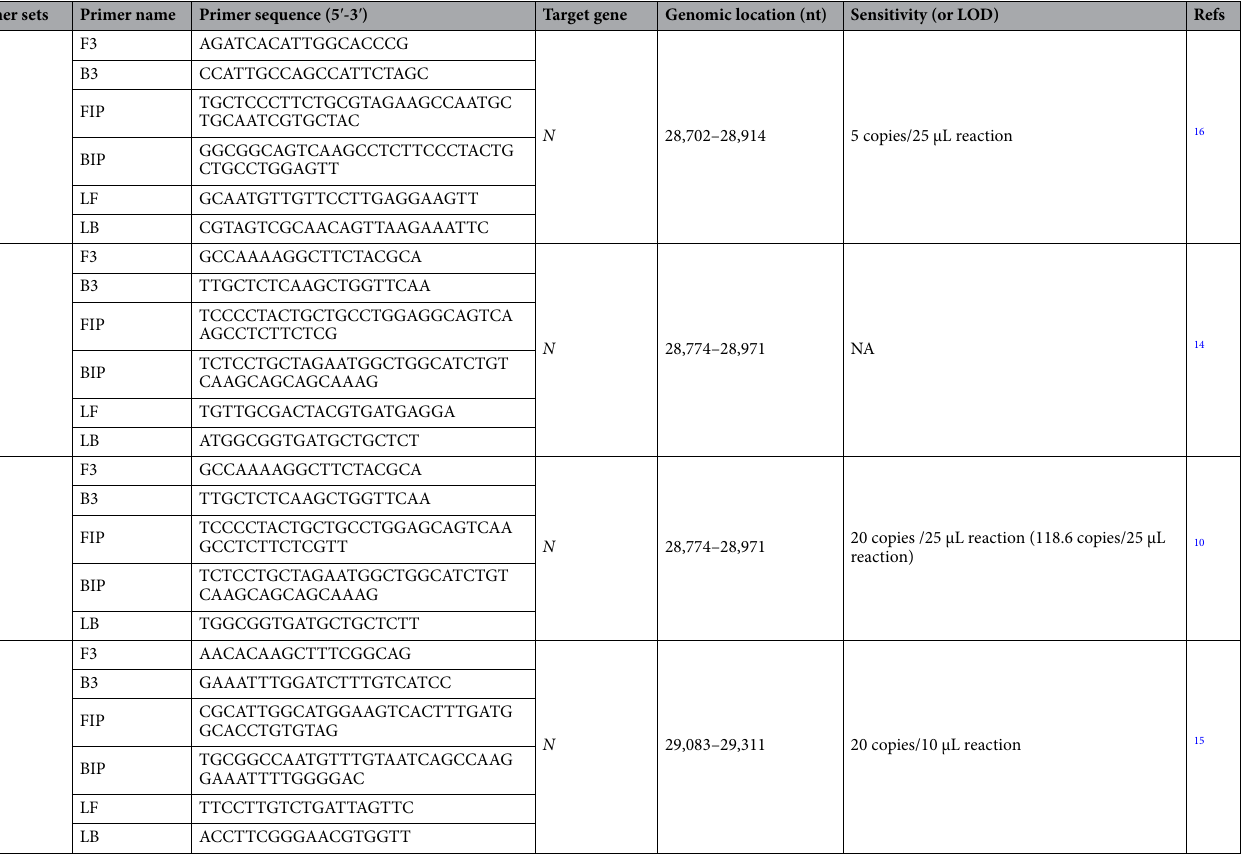
Table 1. Information of 19 sets of RT-LAMP primers for the detection of SARS-CoV-2. F3/B3: outer primers; FIP/BIP: forward and backward internal primers; LF/LB: forward and backward loop